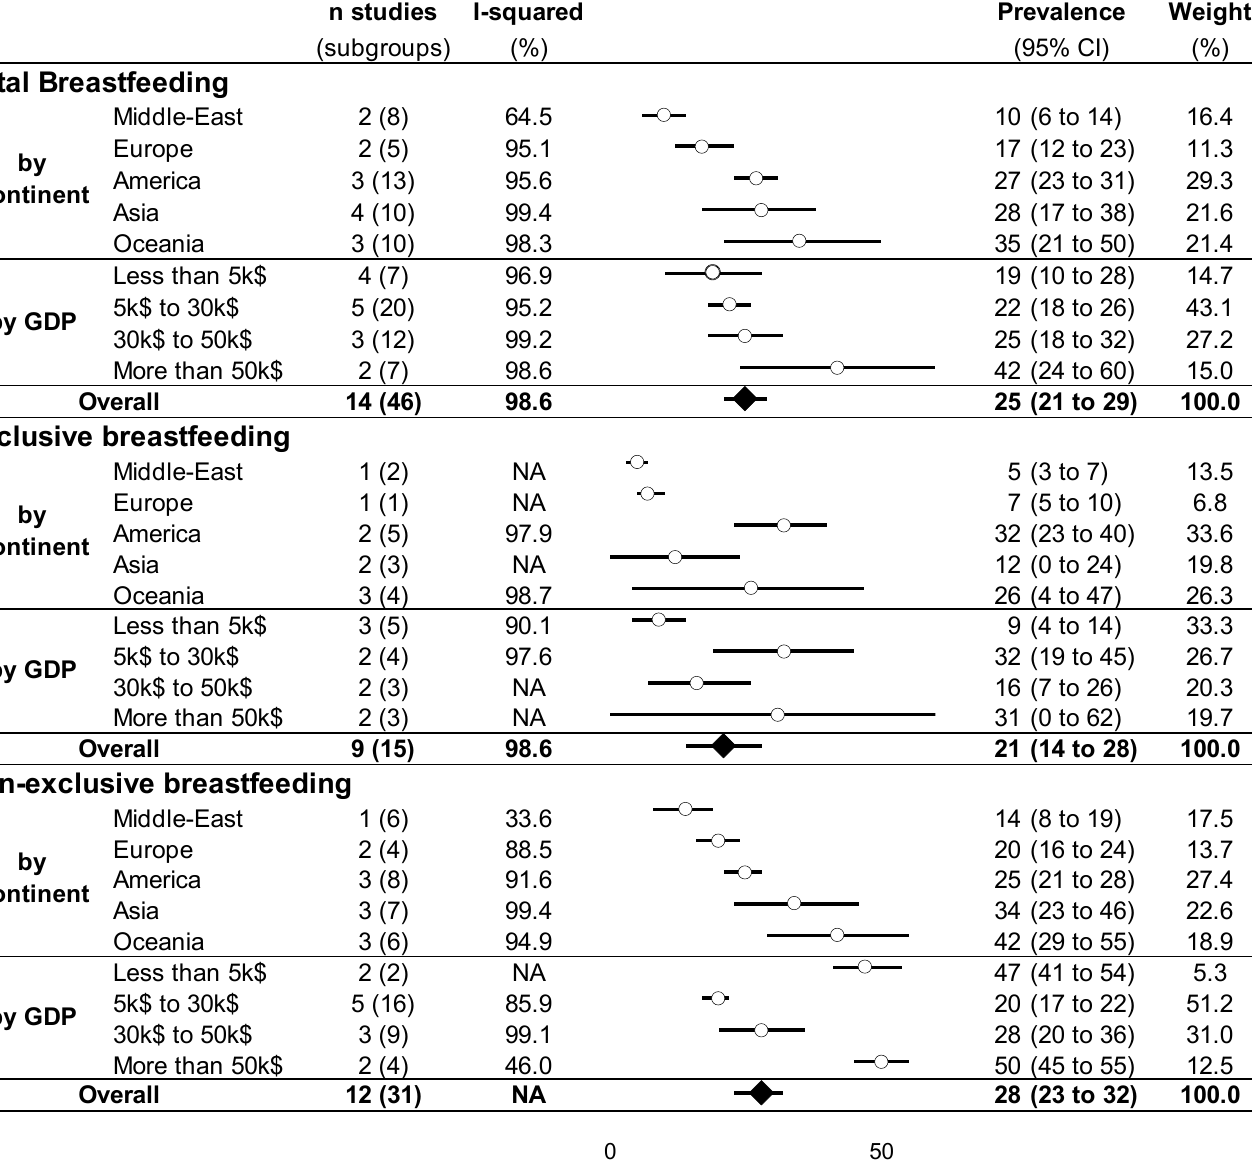
Figure 2. Meta-analysis of the prevalence of breastfeeding.